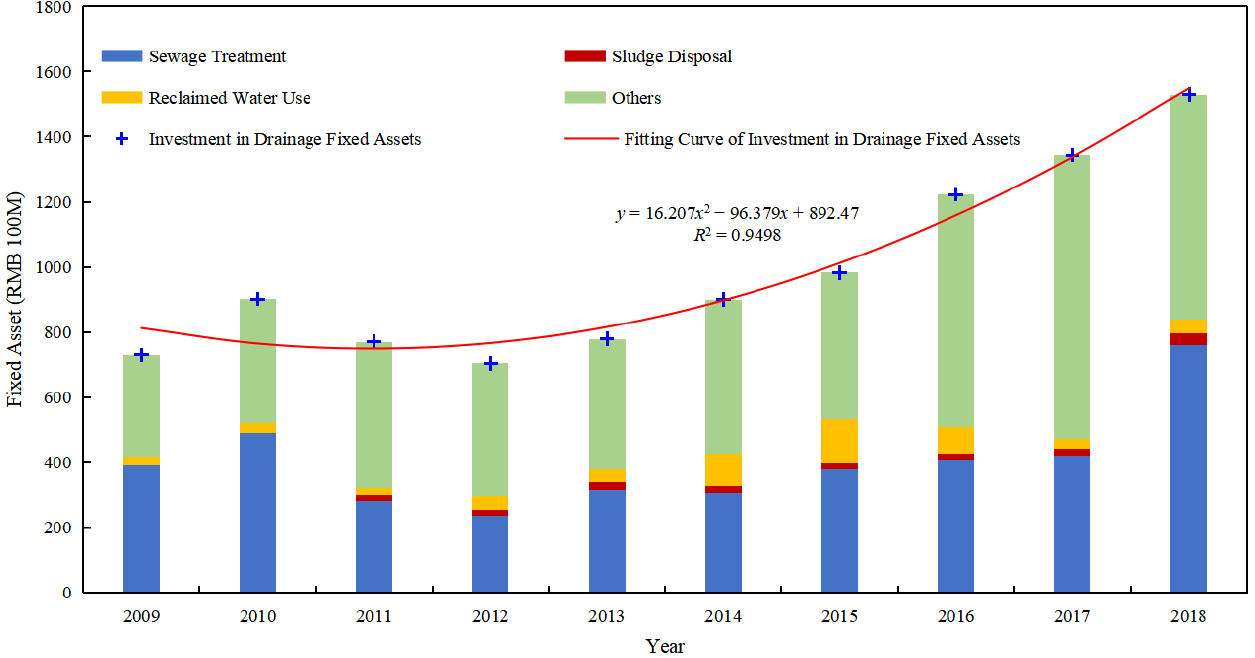
Figure 7. Investment in drainage fixed assets.